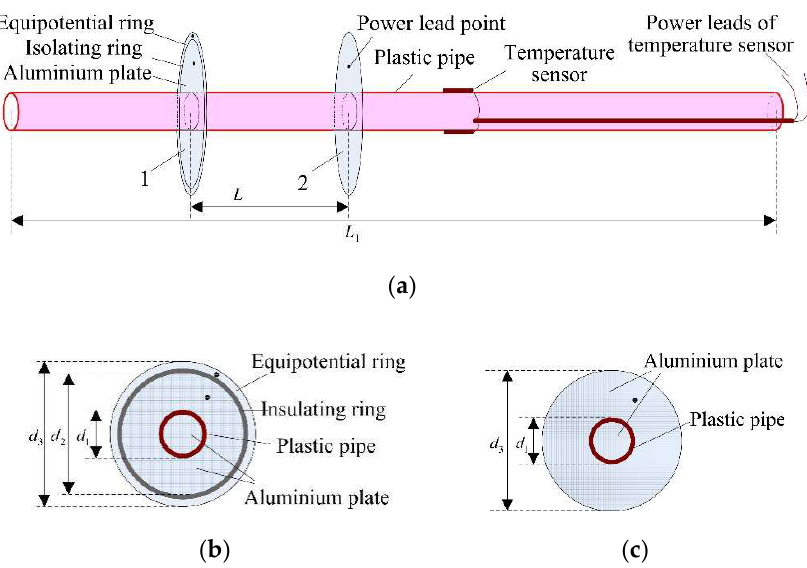
Figure 3. The schematic of the simulation conductor: ( a ) Simulation conductor with two capacitance electrodes; ( b ) no. 1 capacitance electrode; and ( c ) no. 2 capacitance electrode.